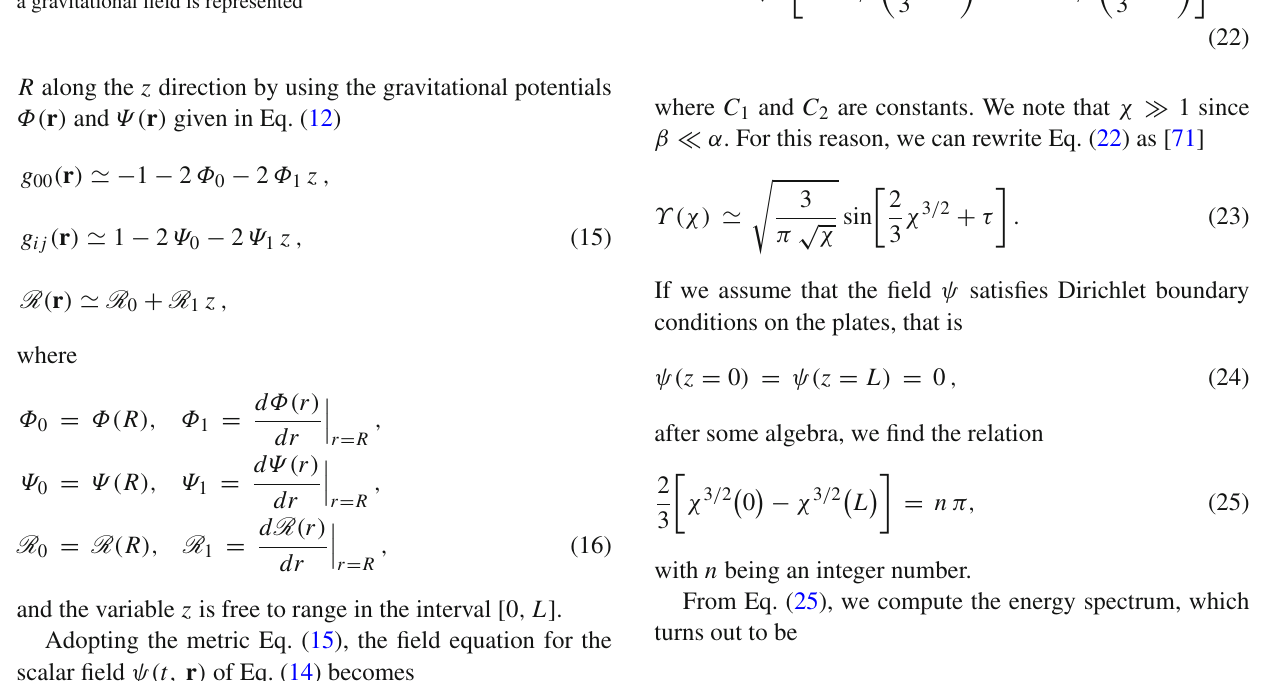
Fig. 1 In this picture, the configuration of the Casimir-like system in a gravitational field is represented